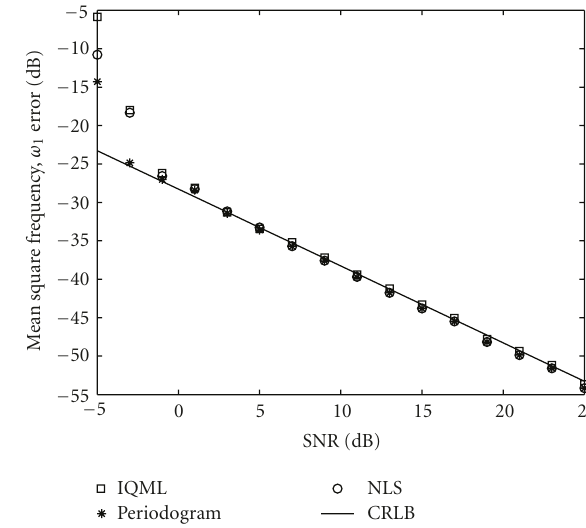
Figure 23: MSE for ω 2 of multiple complex sinusoids versus ω 2 .